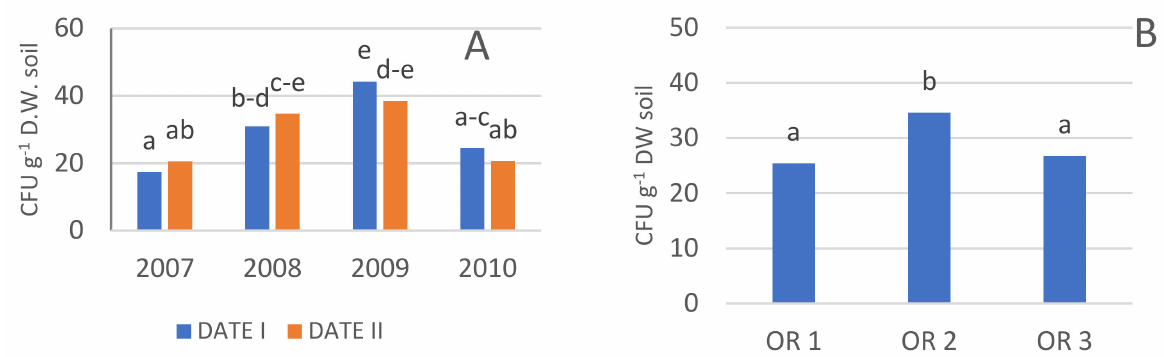
Figure 9. Number Azotobacter in 2007–2010: ( A )—depending on the year and date of sampling; ( B )—depending on the orchard.